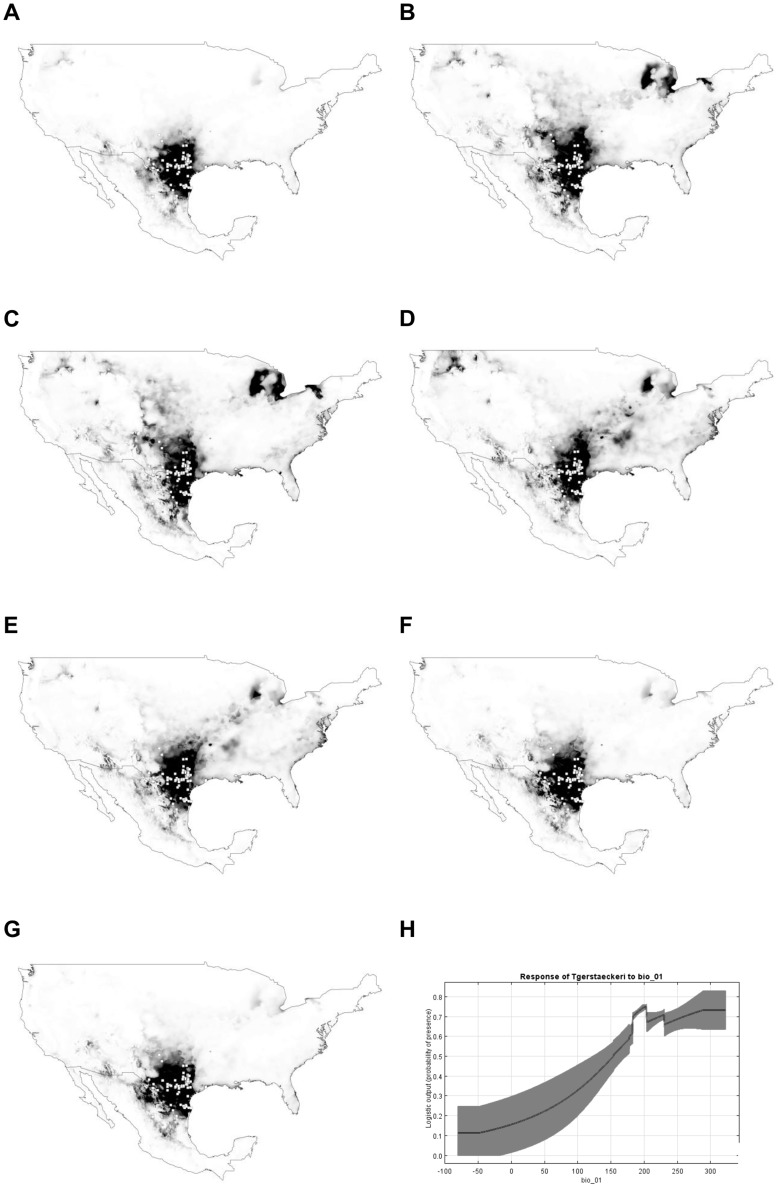
Present (A) and future (2050; B–G) potential distribution for Triatoma gerstaeckeri.All models predict a shift in the distribution of this species towards northern and eastern regions of Mexico and USA. Black color =  high suitable habitat vs. white color =  no suitable habitat for the species. General circulation models and climatic scenarios: B =  CCCMA-A2A; C =  CCCMA-B2A; D = CSIRO-A2A; E = CSIRO-B2A; F = HADCM3_A2A; G = HADCM3_B2A. Variable with most contribution on the species distribution was Annual Mean Temperature (H), which as per the original data (www.worldclim.org) was multiplied by 10.